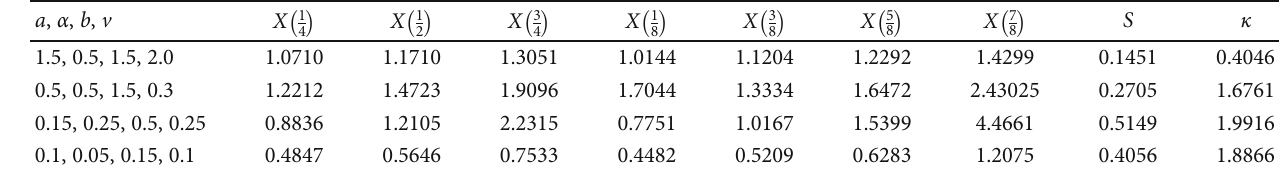
Table 1: Table of values of the Bowley skewness and the Moors kurtosis.